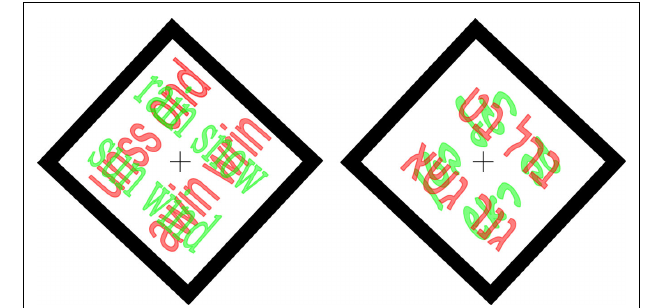
FIGURE 1 | Examples of word-non-word rivaling stimuli. Left English text (rain snow sun wind vs. unss ond awin wrin – pronounceable non-words); Right Hebrew text – as actually used in Experiment 1, since subjects were Hebrew speakers; text in print vs. script